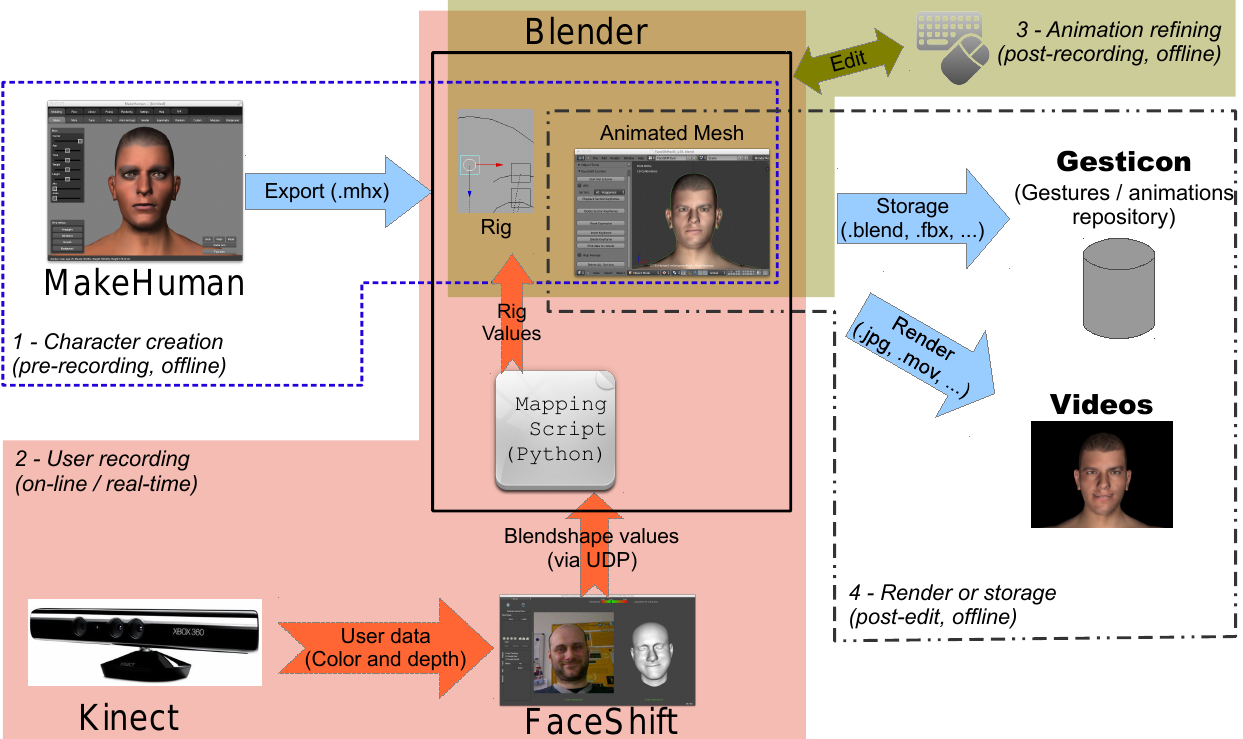
Figure 3. The architecture of the proposed